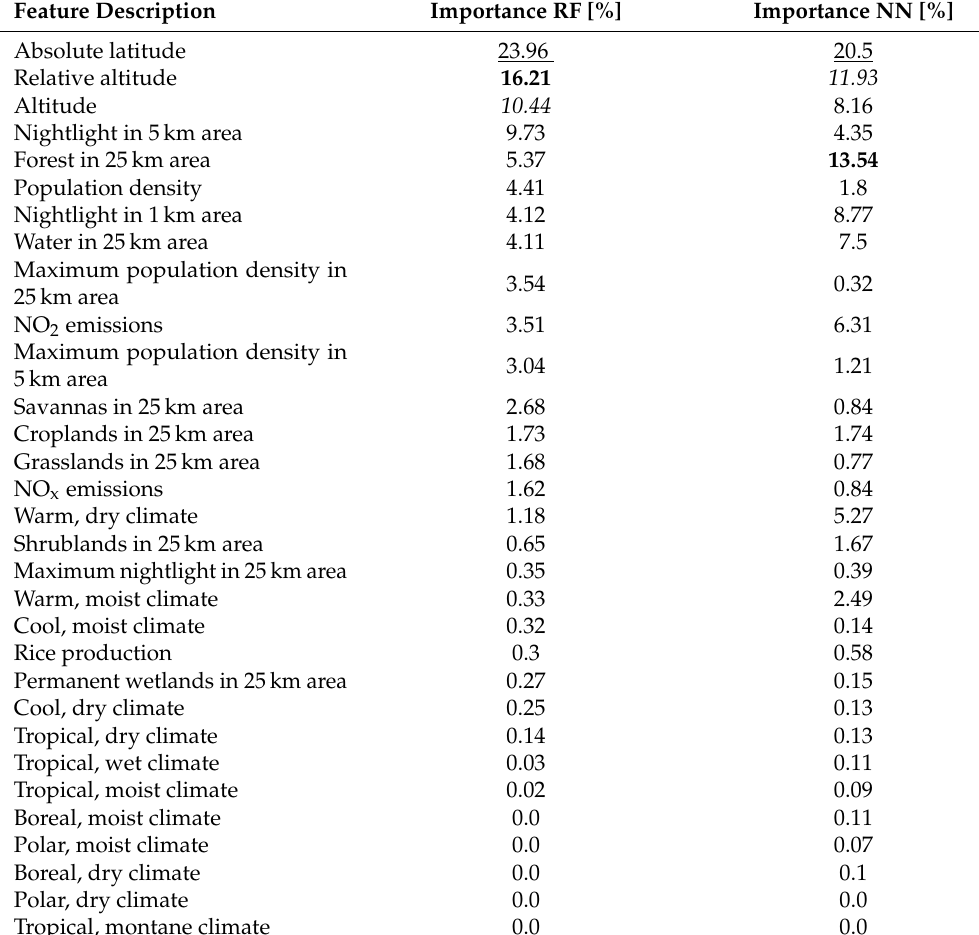
Table 2. Global feature importance derived by SHAP for our trained random forest (RF) and neural network (NN). The first column lists short descriptions of the AQ-Bench features; we kept the order from the most important to the least important in the test set of our random forest. Percentage values for the random forest are shown in the second column, and corresponding values of the neural network are shown in the third column. The largest importance values of both models were underlined, the second largest are shown in bold, and the third largest are shown in italic font. For a table with the AQ-Bench feature names, see Appendix A Table